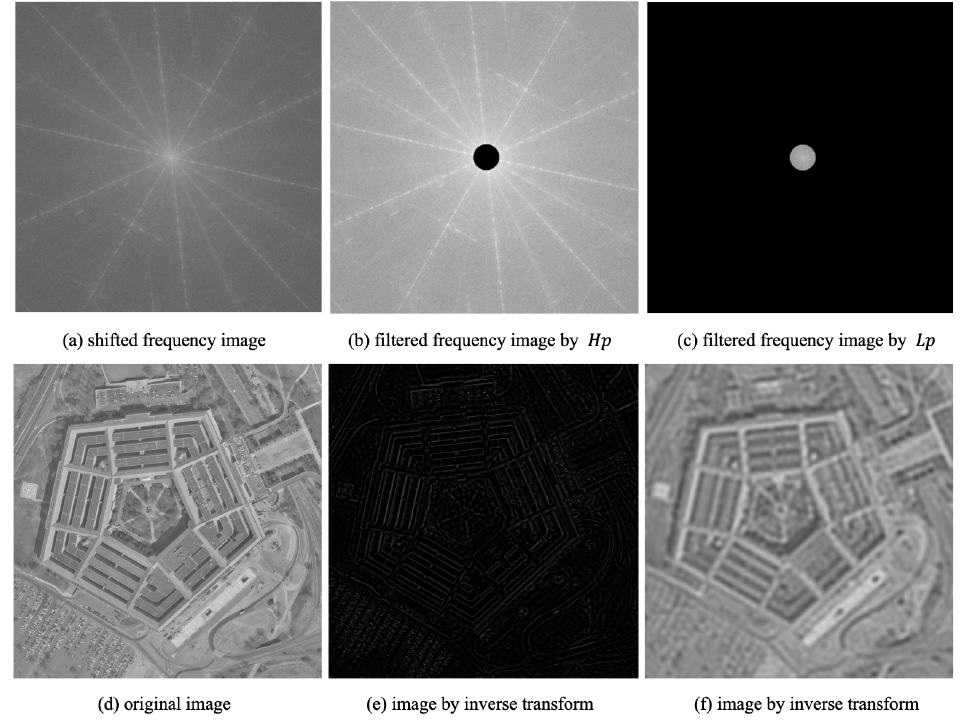
Figure 8. The Fourier frequency images of the filtered image by Hp and Lp and their inverse transform